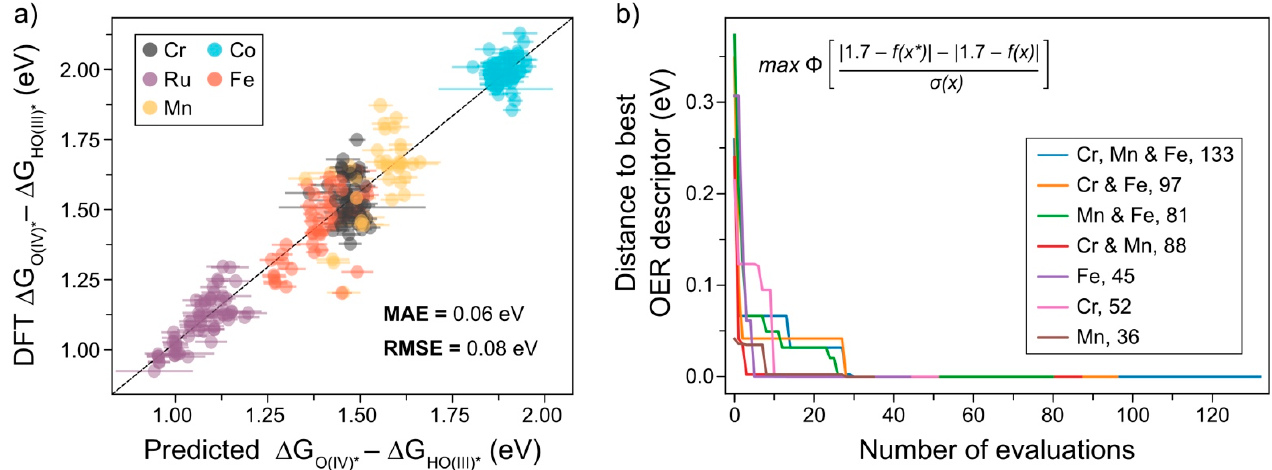
Figure 2. Machine learning applied to OER catalysts: ( a ) results of leave-one-out cross validation using the GPR model for each (cid:1986)(cid:1833) (cid:3016)((cid:3010)(cid:3023)) ∗ −(cid:1986)(cid:1833) (cid:3009)(cid:3016)((cid:3010)(cid:3010)(cid:3010)) ∗ descriptor value. The dashed line represents the equation (cid:1877) = (cid:1876) , while the uncertainties in the predictions are represented as x-axis error bars. ( b ) Bayesian optimization starting from different sets of unseen data, showing the number of evaluations needed to converge to the desired (cid:1986)(cid:1833) (cid:3016)((cid:3010)(cid:3023)) ∗ −(cid:1986)(cid:1833) (cid:3009)(cid:3016)((cid:3010)(cid:3010)(cid:3010)) ∗ value as dictated by the probability of improvement acquisition function, depicted in the top left. When maximized, this function iteratively determines the most promising catalyst to evaluate. This equation and the terms are explained in the main text.